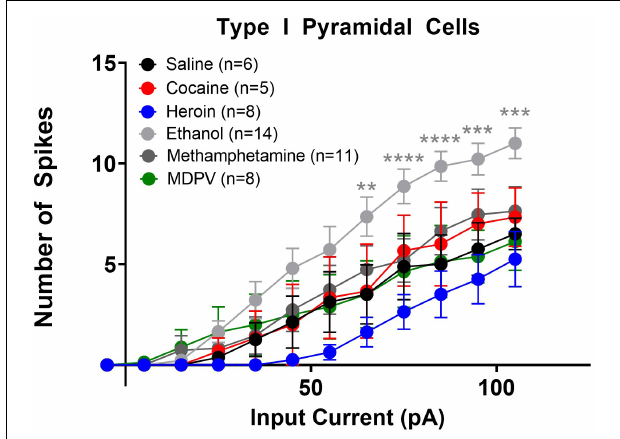
FIGURE 5 | Ethanol increases the excitability of type I layer V pyramidal cells. Ethanol significantly increased the number of action potentials elicited with higher depolarizing currents in type I cells, relative to saline. Specifically, ethanol significantly increases the number of action potentials elicited by currents 65–105 pA. Cocaine, heroin, methamphetamine, and MDPV had no effect on the number of depolarization-induced action potentials in type I cells. **, ***, and **** indicate p < 0.01, p < 0.001, and p < 0.0001 saline versus ethanol, respectively. Cell numbers are indicated within figure